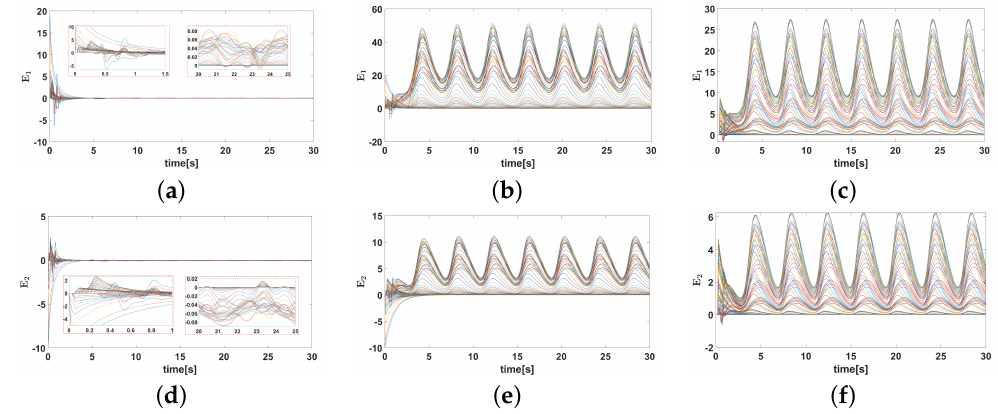
Figure 12. The estimation error based on the CLIRBFNN, IRBFNN, and RBFNN. ( a – c ) show the estimation error of Joint 1. ( d – f ) show the estimation error of Joint